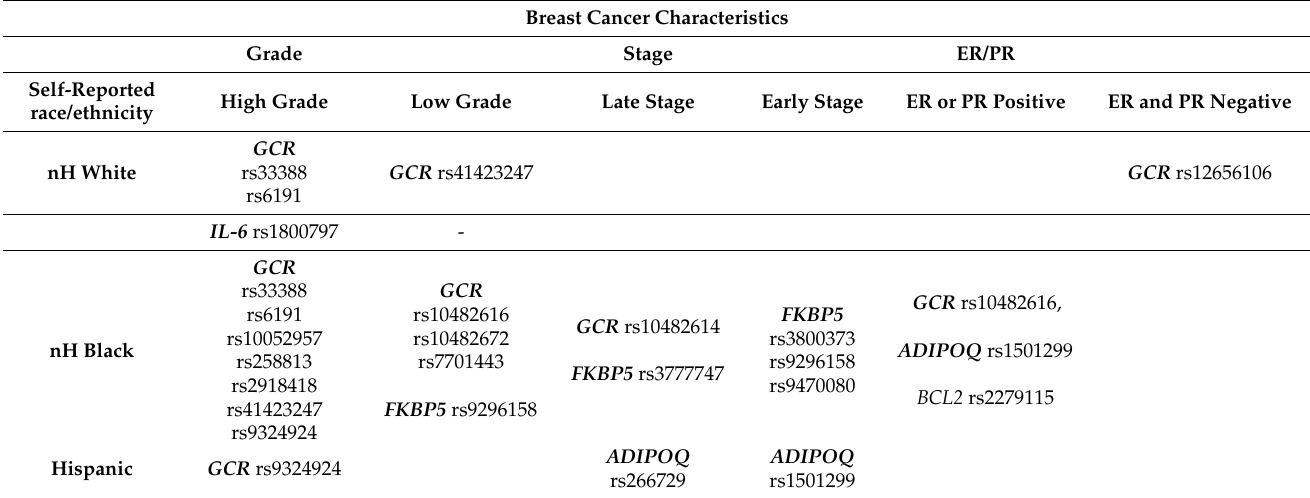
Table 5. Summary of significant associations between genetic variants and breast cancer